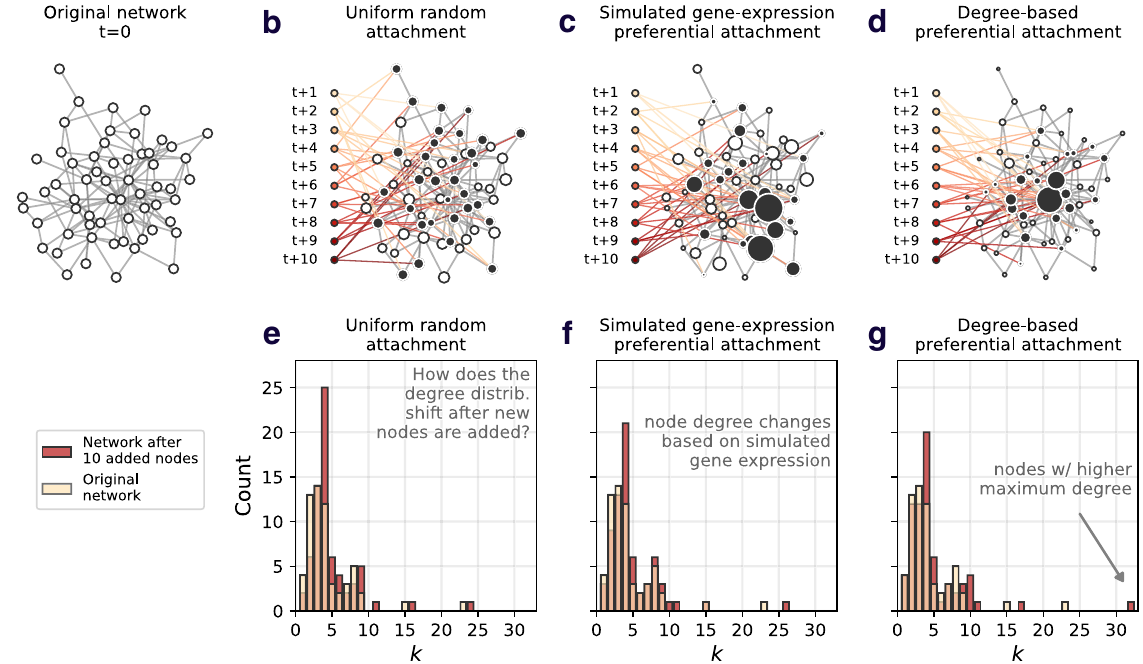
Fig. 3 The effect of attachment mechanism on network structure. A visual depiction of the effect of adding nodes under different attachment mechanisms. In each example, 10 nodes are added, connecting their m = 4 links to nodes in the original network (indicated by the black nodes). Node size corresponds to its likelihood of gaining new links. a Example network, before node addition. b Example of uniform attachment. c Example of (simulated) gene expression preferential attachment. d Example of degree-based preferential attachment. e – g Depicts the change in the original network ’ s degree distribution after the addition of 10 nodes, under each attachment mechanism (uniform, gene expression, and degree based). The white bars are transparent to show overlap. While these histograms highlight the change in a single network property (degree, k ), one can imagine a number of structural changes occurring following the addition of new nodes, depending on the attachment mechanism.